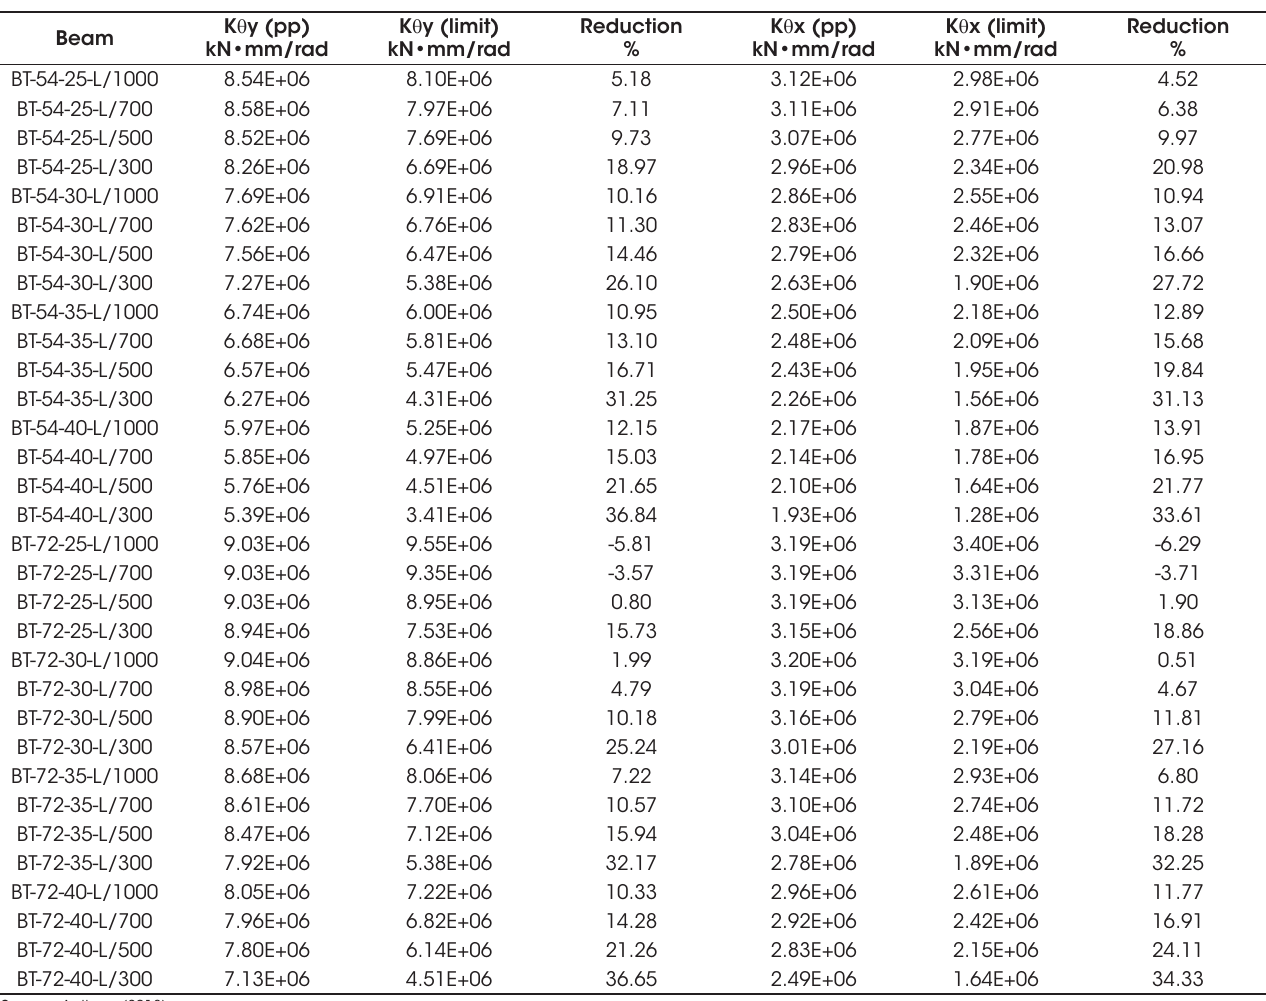
Differences between pad stiffness